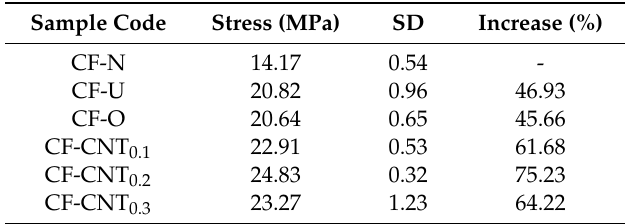
Table 3. Bond strength of samples cured under atmospheric